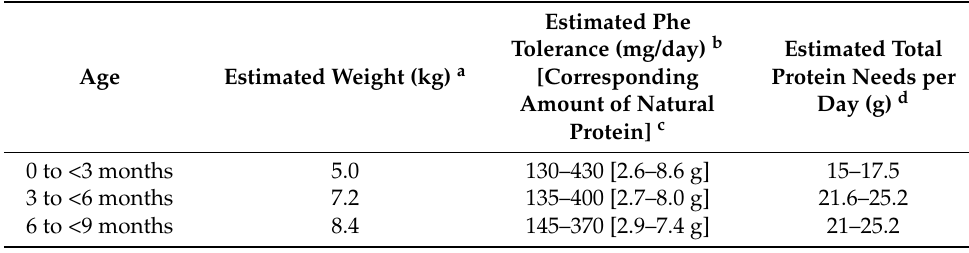
Table 1. Comparison of phenylalanine (Phe) tolerance vs. total protein requirements recommended for individuals with